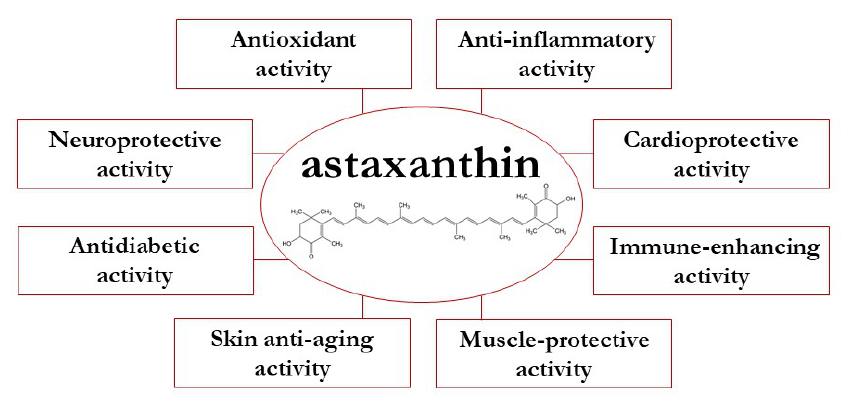
Figure 1. Bioactivity and health benefits of astaxanthin. Biological Activity of